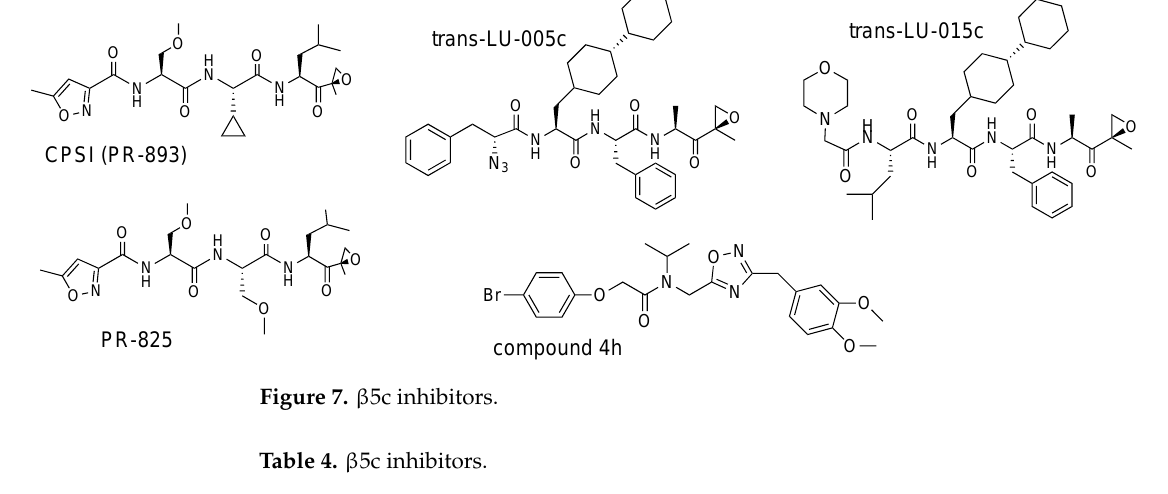
Figure 7. β 5c inhibitors. Table 4. β 5c inhibitors.